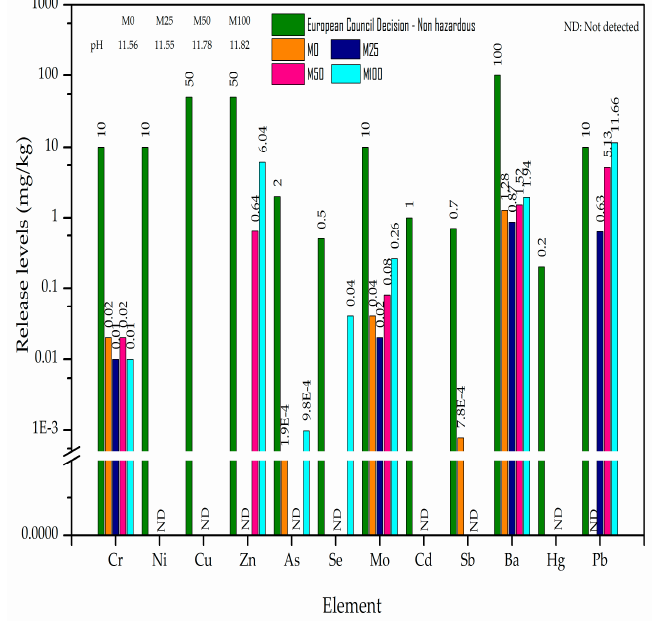
Figure 1. Release level of elements in mortars (XP X31-211).